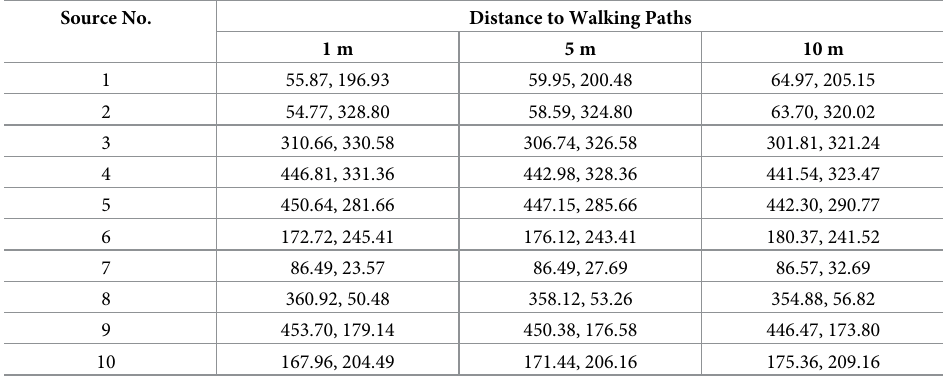
Source locations are shown with two numbers, meaning the location (in meters) in West-East direction and South- North direction corresponding to Fig 1.